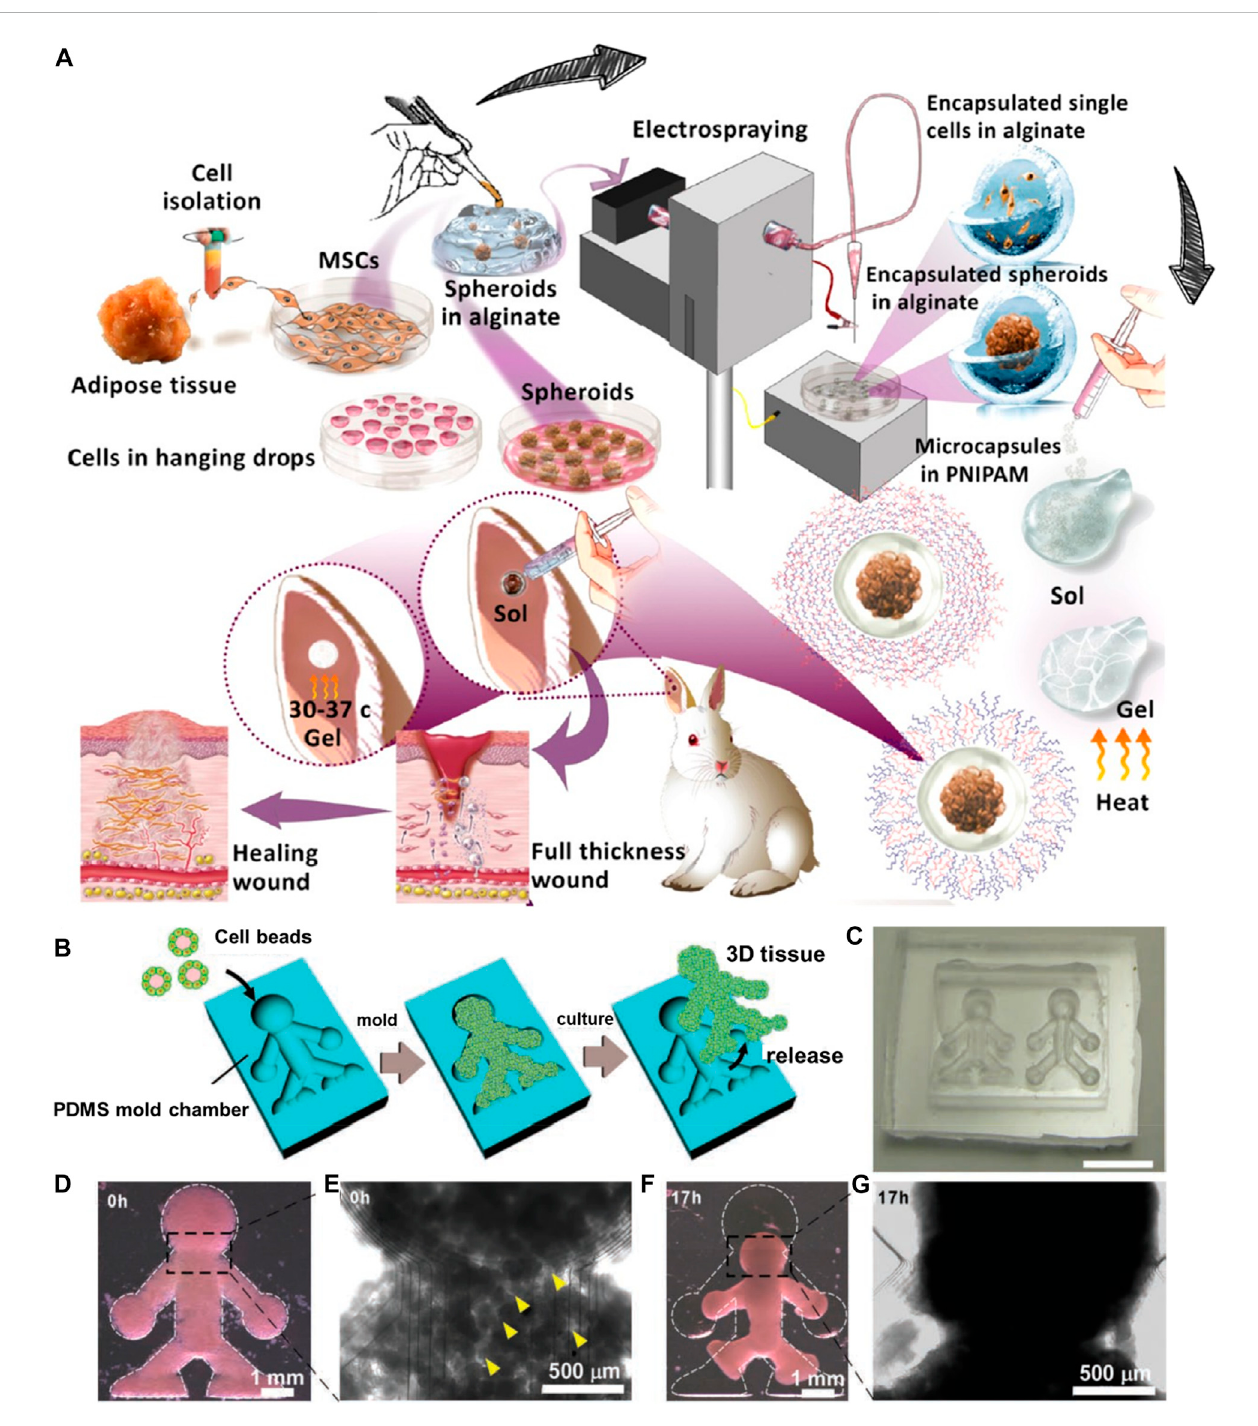
FIGURE 6 (A) Schematic illustration of the electrospray setup used for microencapsulation. Reproduced with permission from Ref. (Nilforoushzadeh et al., 2020). Copyright 2020, American Chemical Society. (B) The method used to produce the 3D tissue architectures using monodisperse cell beads. (C) A microscopy image of the doll-shaped PDMS mold chamber reveals 3D tissue formation. (D,E) Microscopy images of NIH/3T3 cell beads immediately after stacking. Cavities (indicated with yellow arrows) among the cell beads are observed at this time point (0 h). (F,G) Microscopy images of NIH/3T3 cell beads, 17 h after stacking. Reproduced with permission from Ref. (Matsunaga et al., 2011). Copyright 2011, John Wiley &